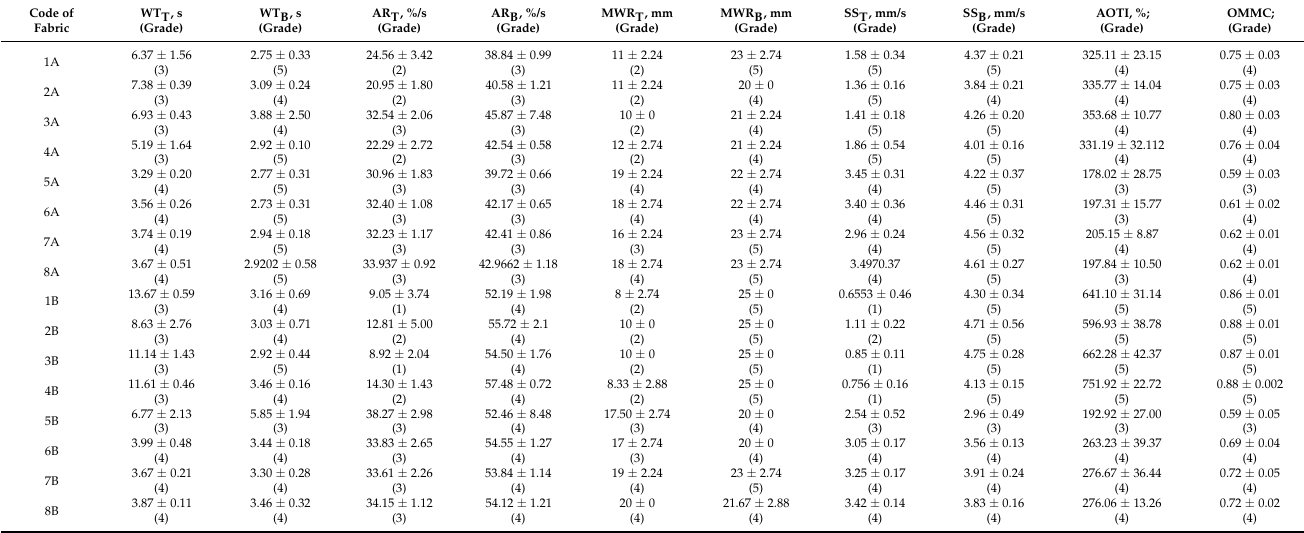
Table 6. Summary data of moisture management properties of